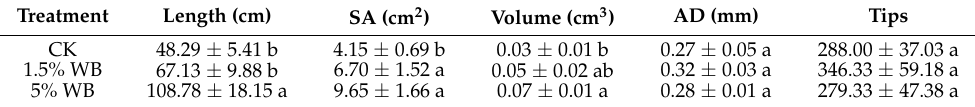
Table 1. Effect of biochar on the root morphology of wild soybean in a coastal soil.